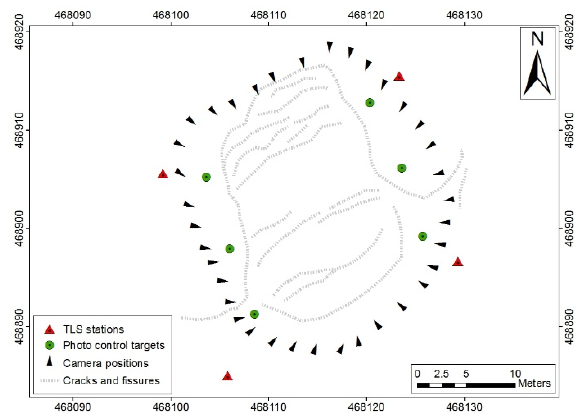
Figure 2. Camera positions for photogrammetric image capture.